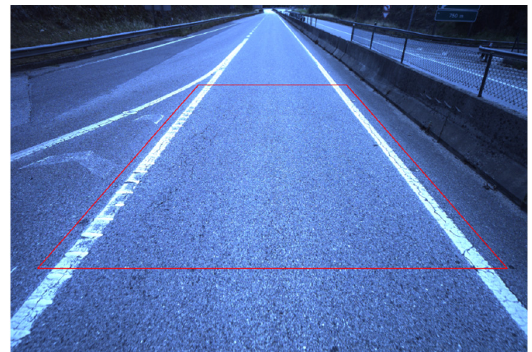
Figure 6. Sample image acquired by the proposed system. The area of interest for analysis is delimited in red.